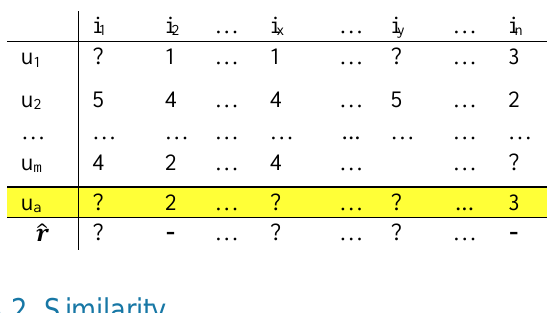
Table 2. Data model with Rating matrix